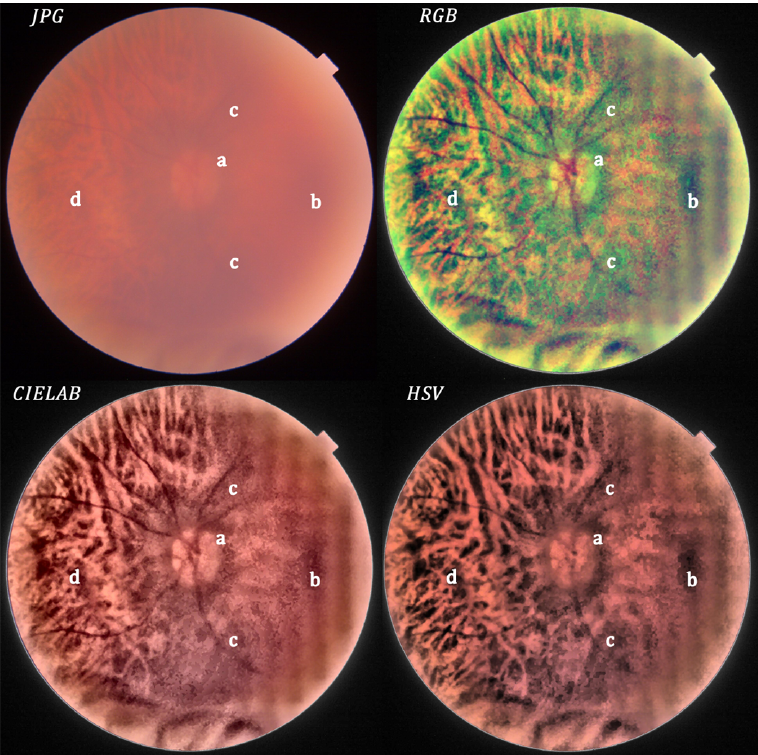
Figure 8. Severe cataract: original (upper left) and processed image.